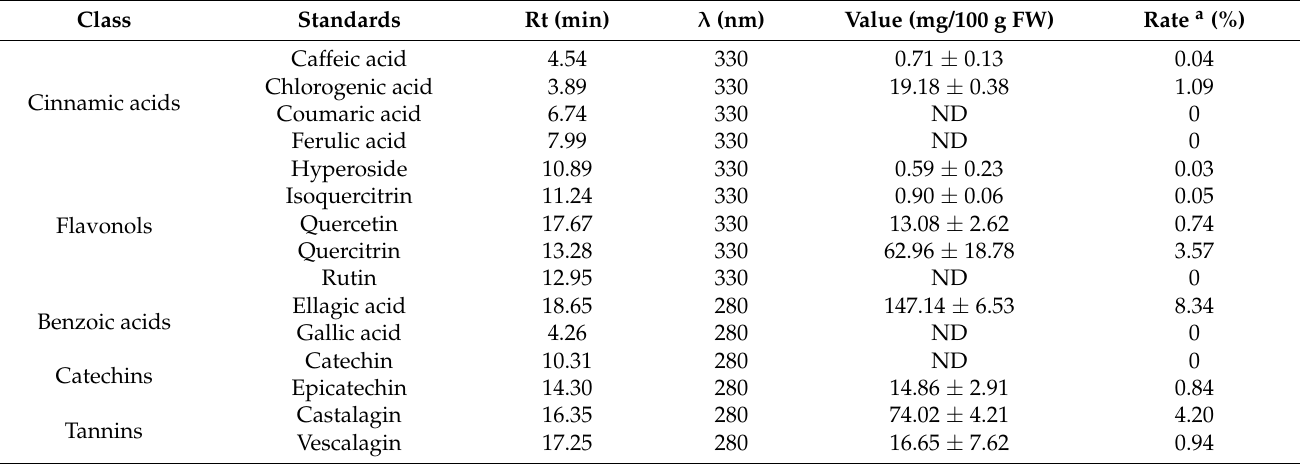
Table 3. Phytochemical contents in the fruit of U. bojeri